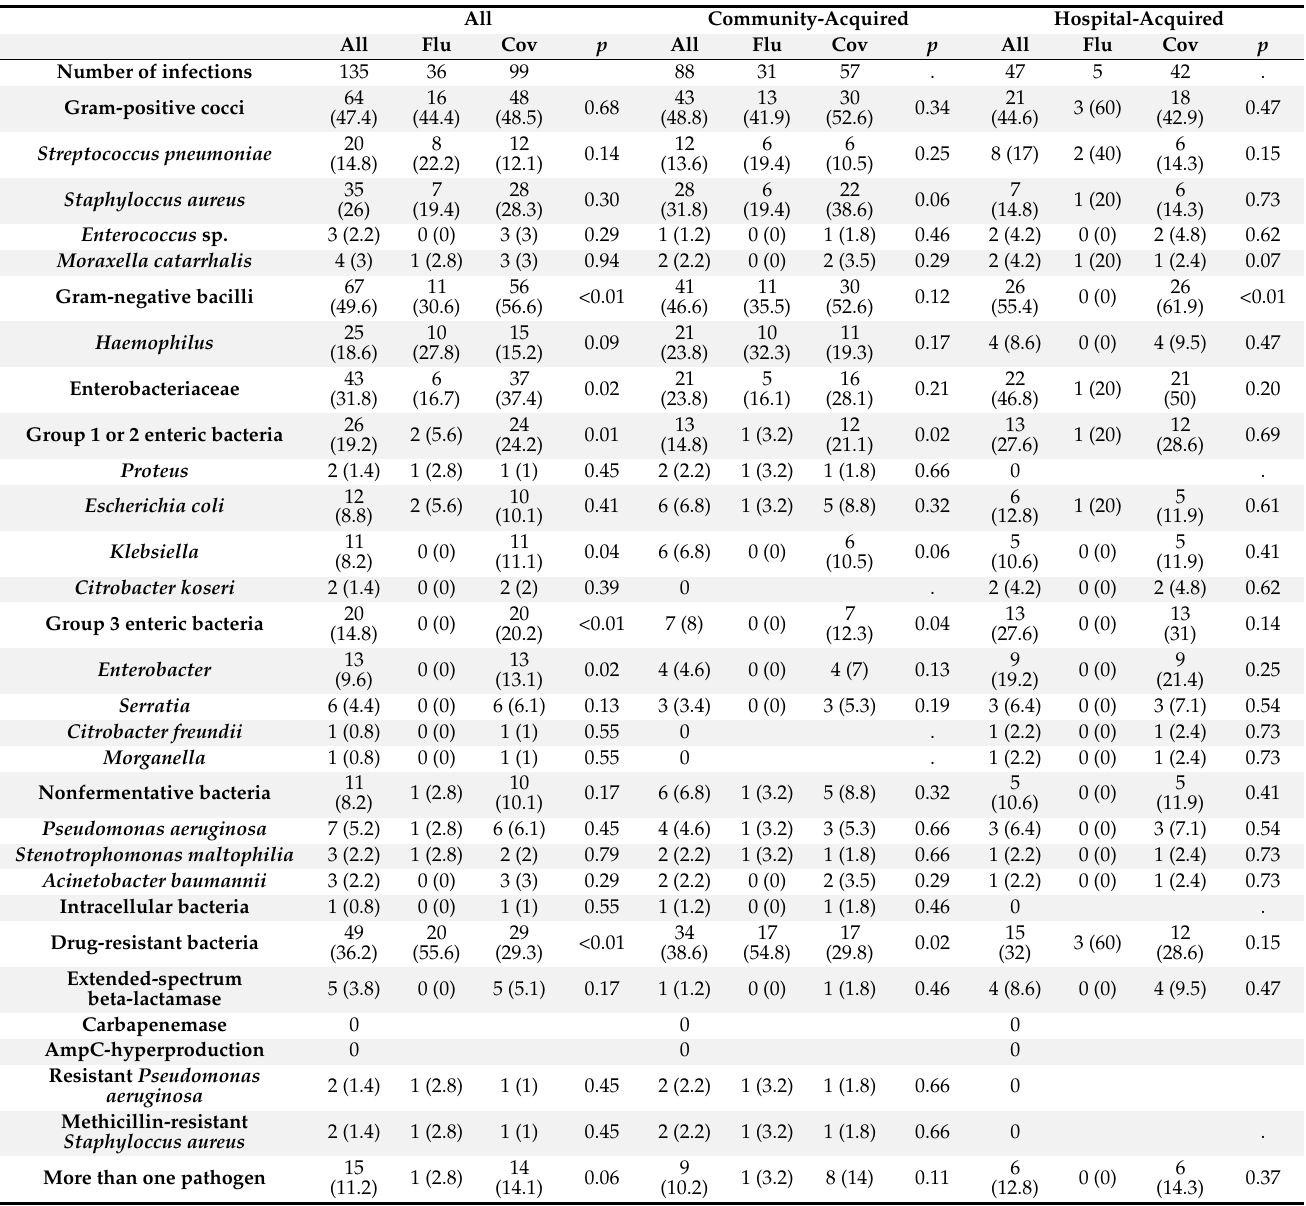
Table 3. Microbiological description of causal agents identified in respiratory bacterial co-infections on